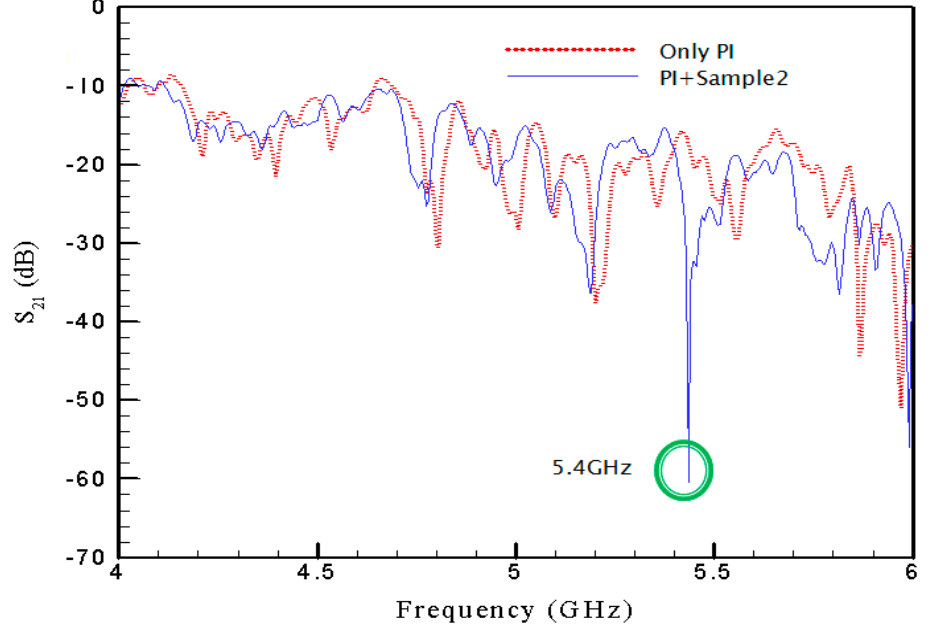
Figure 9. Transmission coefficient with SRR2.